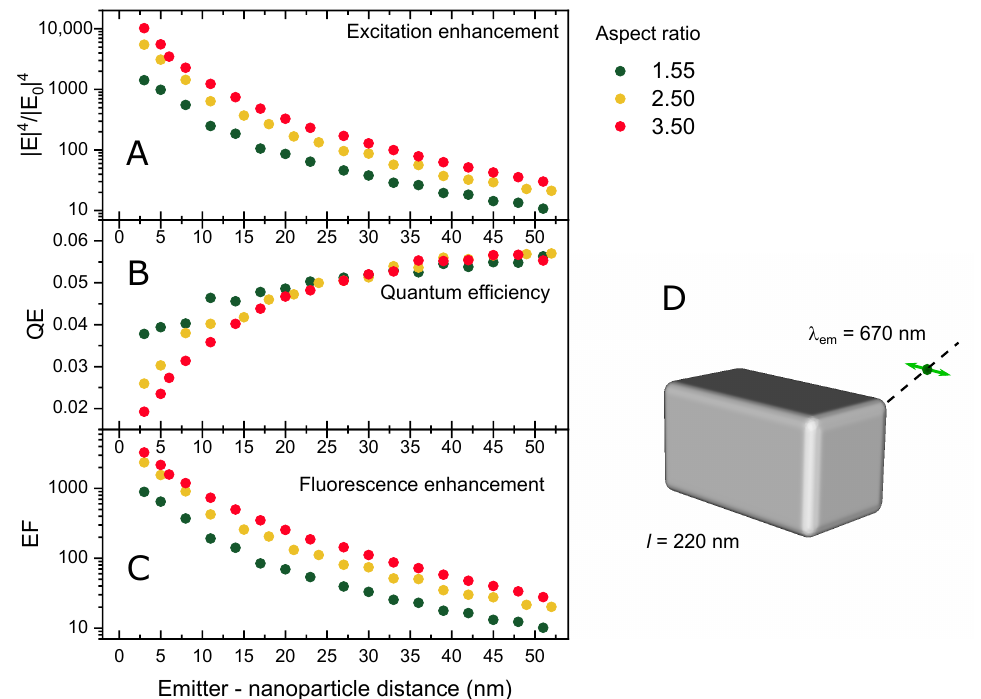
Figure 4. Two-photon excitation rate enhancement ( A ), quantum efficiency ( B ), and two-photon fluorescence intensity enhancement ( C ) as a function of the distance between the fluorophore and the NB along the diagonal for the nanobars with various aspect ratios; schematics of the emitter–nanobar configuration ( D ). The dashed line shows the scanning direction and the green arrow indicates the emitter’s polarization.